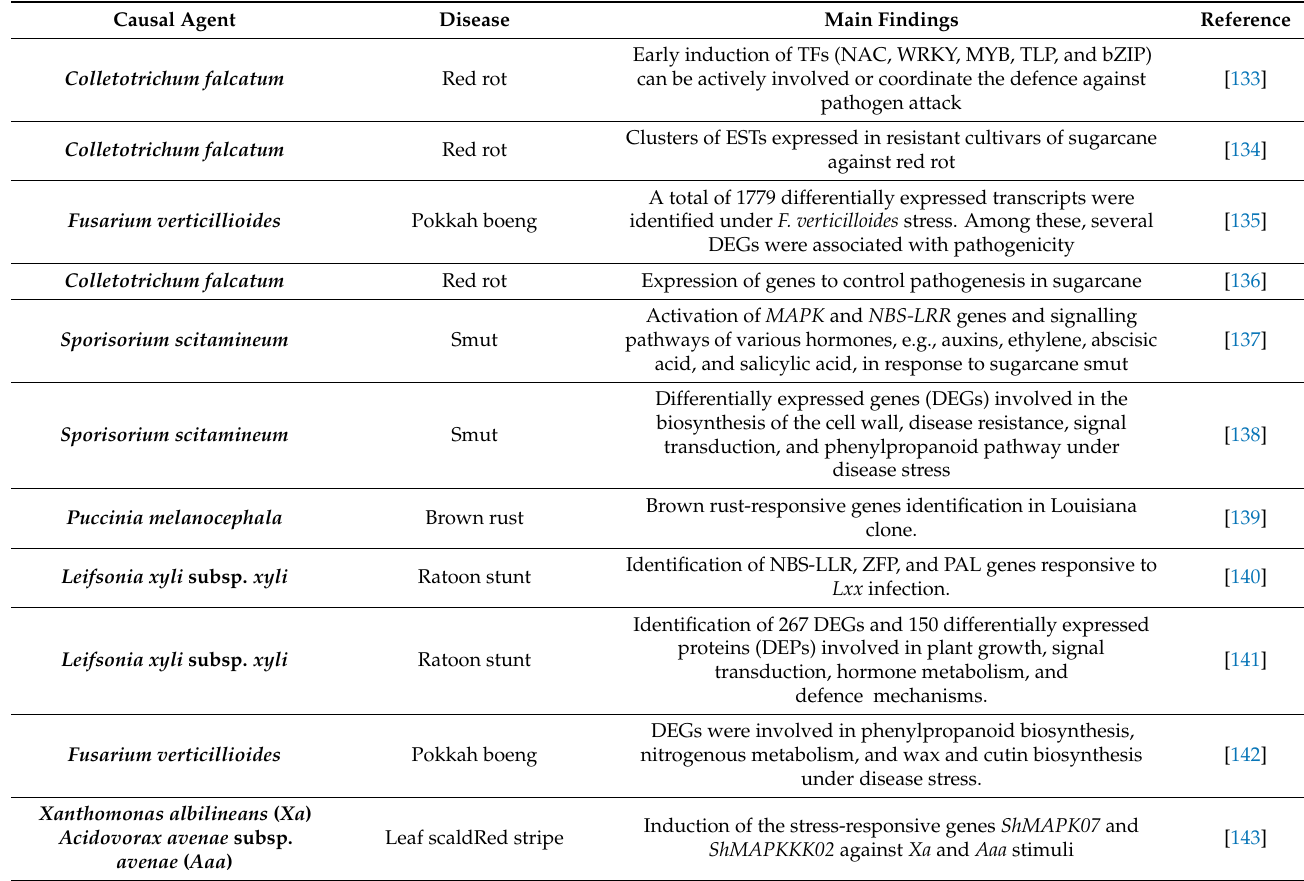
Table 1. Biotic stresses and potential control in